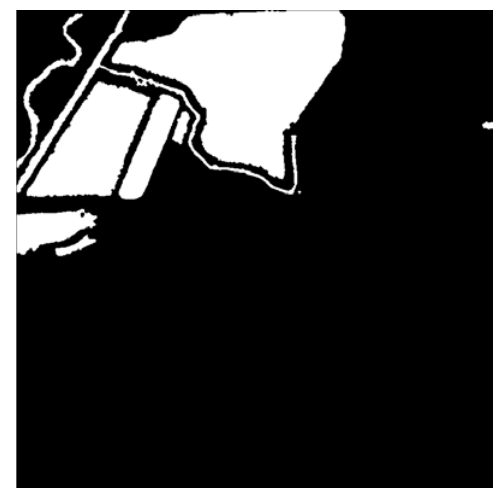
Figure 9. Water body detected after merging detection from elevation and intensity data 2.7 Creating 3D break lines for detected water bodies After detecting water bodies, we identified vertices from the edges of the detected water bodies to create vectors for the break lines. To generate 3D break lines, the median value of the elevation of each water body (calculated from 2m DEM) is chosen as the z value. 3D break lines for the detected water bodies are shown in figure 10. Though we used a vertical exaggeration factor of 10, the elevation difference is not clearly noticeable as all the water bodies have almost same